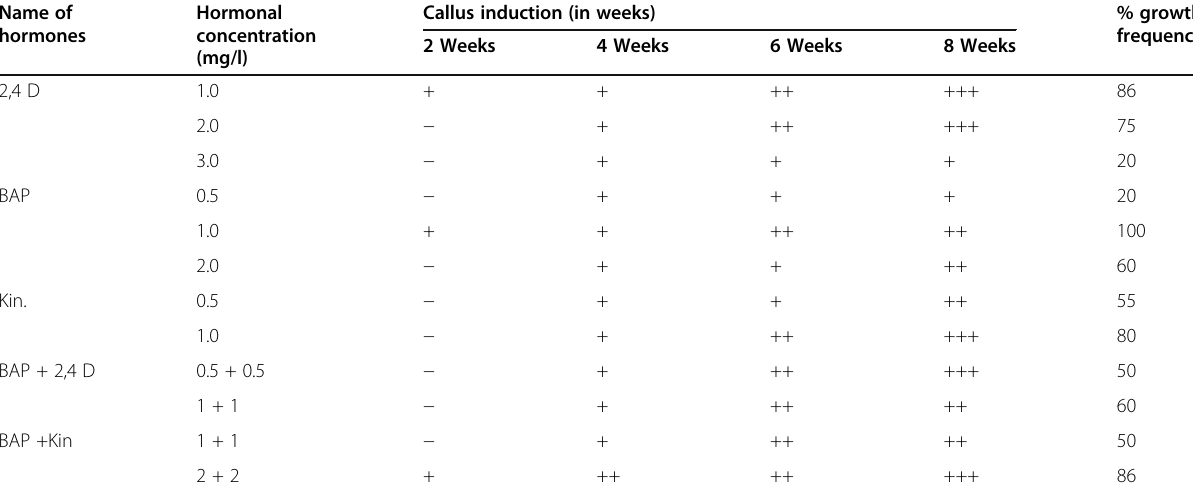
Table 1 Effect of different hormones on callus formation from leaf explants of CP Willd. Name of